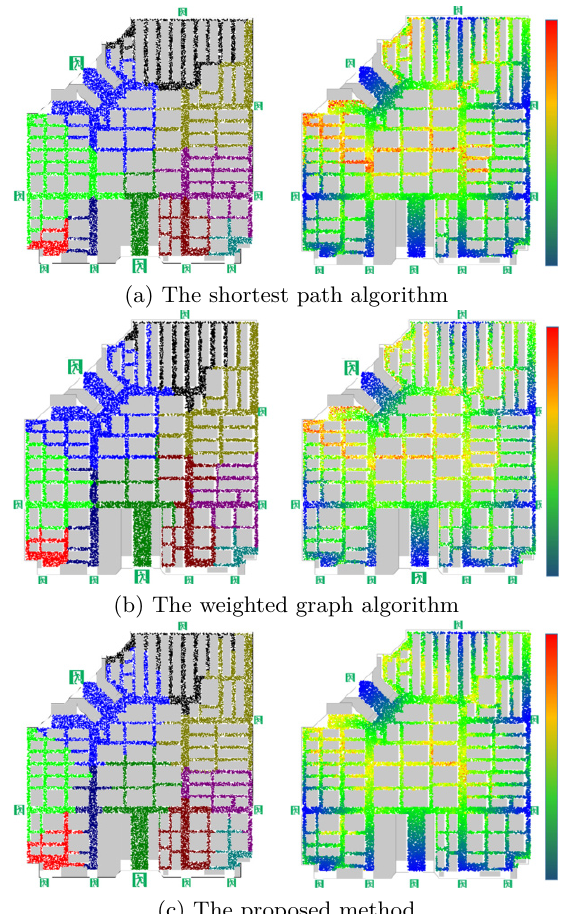
Fig. 7 Exhibition example. We compare the results determined by: (a) the shortest path algorithm, (b) the weighted graph algorithm, and (c) our proposed method. Left: color indicates agents assigned to the same exit. Right: color indicates evacuation time of each agent. Agents who follow guidance determined by our method evacuate faster than in the other two cases.